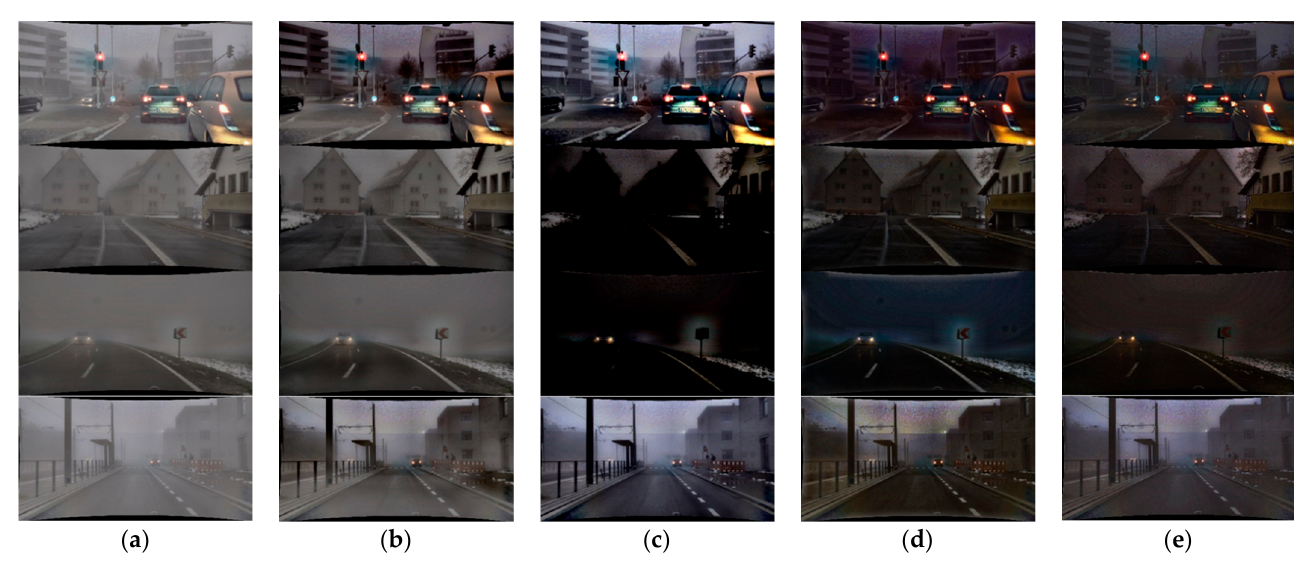
Figure 17. Results of various algorithms: ( a ) hazy input; ( b ) proposed; ( c ) Fattal; ( d ) He; ( e ) Tan.